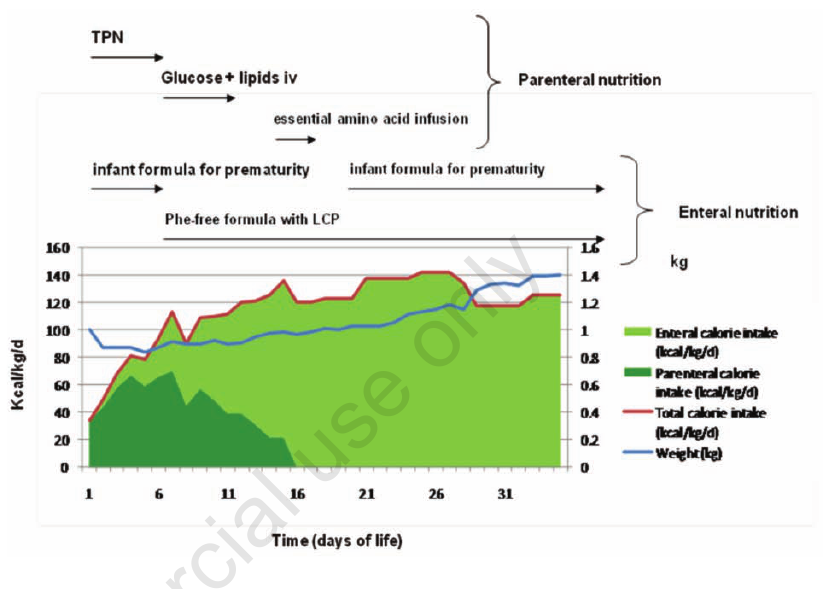
Figure 1. Evolution of parenteral and enteral nutrition during the first 35 days of life: the body weight (kg) is indicated by the blue curve, total calorie intake (kcal/kg/d) by the red curve. Proportions of parenteral (dark green) and oral (light green) nutrition are demonstrated. Start and duration of specific products is marked above the